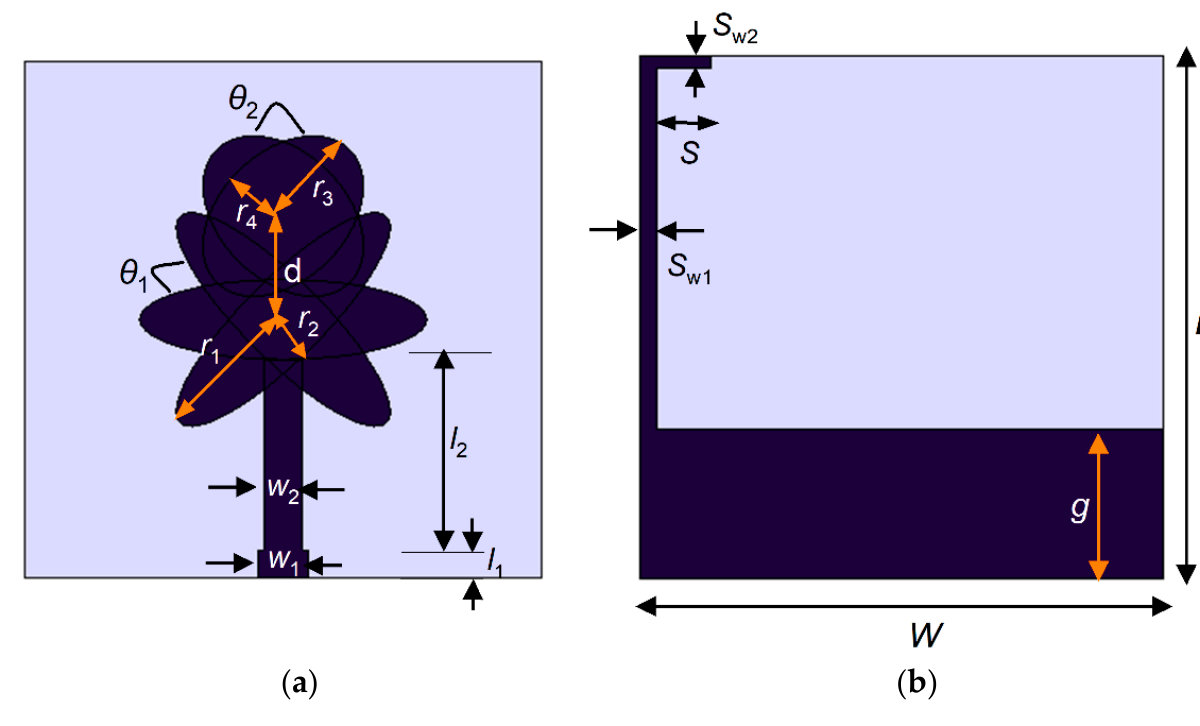
Figure 1. Proposed ultra-wideband (UWB) antenna ( a ) front view ( b ) back view.